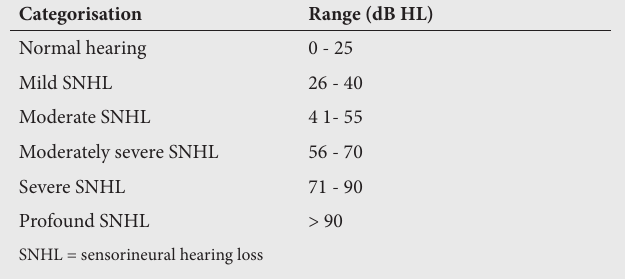
Table 2. Categorisation of hearing